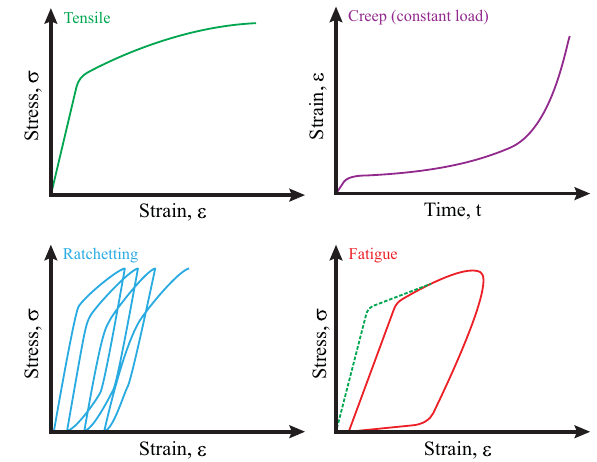
Fig. 2 Schematic description of loading modes. The amount of strain ( ε ) that develops in a uniaxially loaded material depends on both the applied stress ( σ ) and the loading conditions (tensile, creep, ratchetting, and